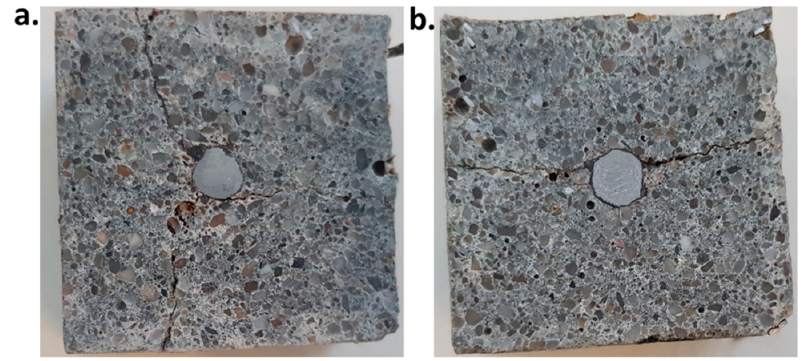
Figure A2. Cross-section of ( a ) CA-24h; ( b ) CA-28d at the end of conditioning.